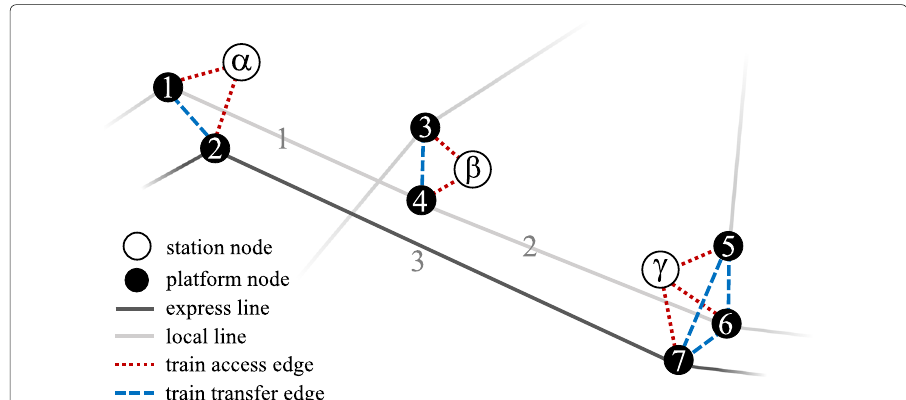
Fig. 2 Diagram of the train network construction scheme. White station nodes α , β , and γ represent the physical stations and red dashed edges represent access links connecting the station to each of its platforms. Each type of train on each train line is represented by a separate platform node (black nodes) which are connected to each other by train lines (gray) at different stations and transfer edges (blue dashed lines) at the same station. In this example, lines 1 + 2 and 3 run on the same tracks and both use stations α and γ , but line 3 represents an express train that doesn’t stop at station β . Only the station nodes are connected to nodes of the other transportation